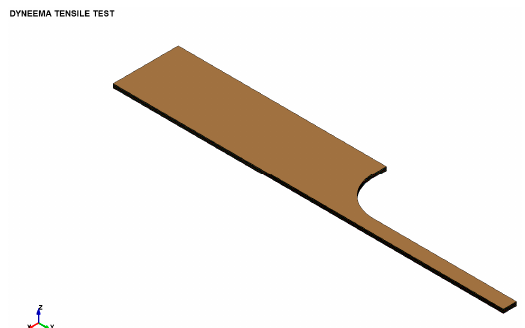
Figure 15. Finite element model (eighth symmetry) with ten layers.